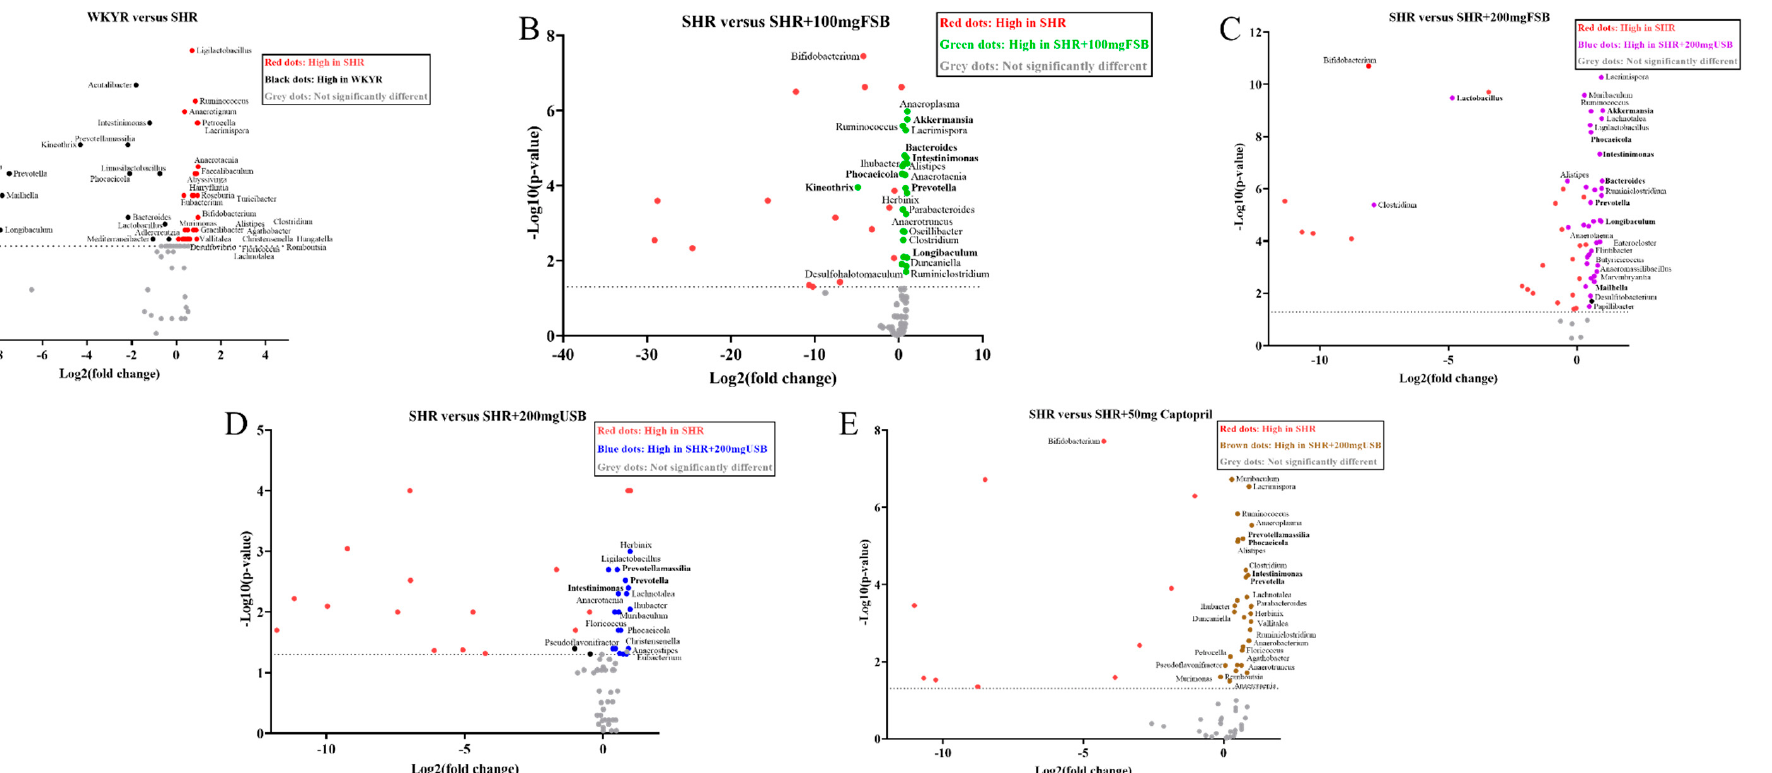
Figure 5. Characteristic microbiota taxonomic profile changes associated with the soybean product consumed: Volcano plots of differential bacterial abundance associated with the ( A ). WKYR and SHR, ( B ). SHR and SHR +100 mg FSB, ( C ). SHR and SHR + 200 mg FSB, ( D ). SHR and SHR + 200 mg USB, ( E ). SHR and SHR + 50 mg Captopril. Fold change associated with a unit change in the corresponding test and Benjamini–Hochberg-adjusted p values are plotted for each taxon. Significantly different taxa are colored according to genus and the names of genera increased after intervention are named. Bolden genera indicate taxons that were significantly abundant in WKYR but became abundant in SHR only after feeding them with USB or FSB. The dotted line shows where p = 0.05 with points above the line having p < 0.05 and points below the line having p > 0.05.